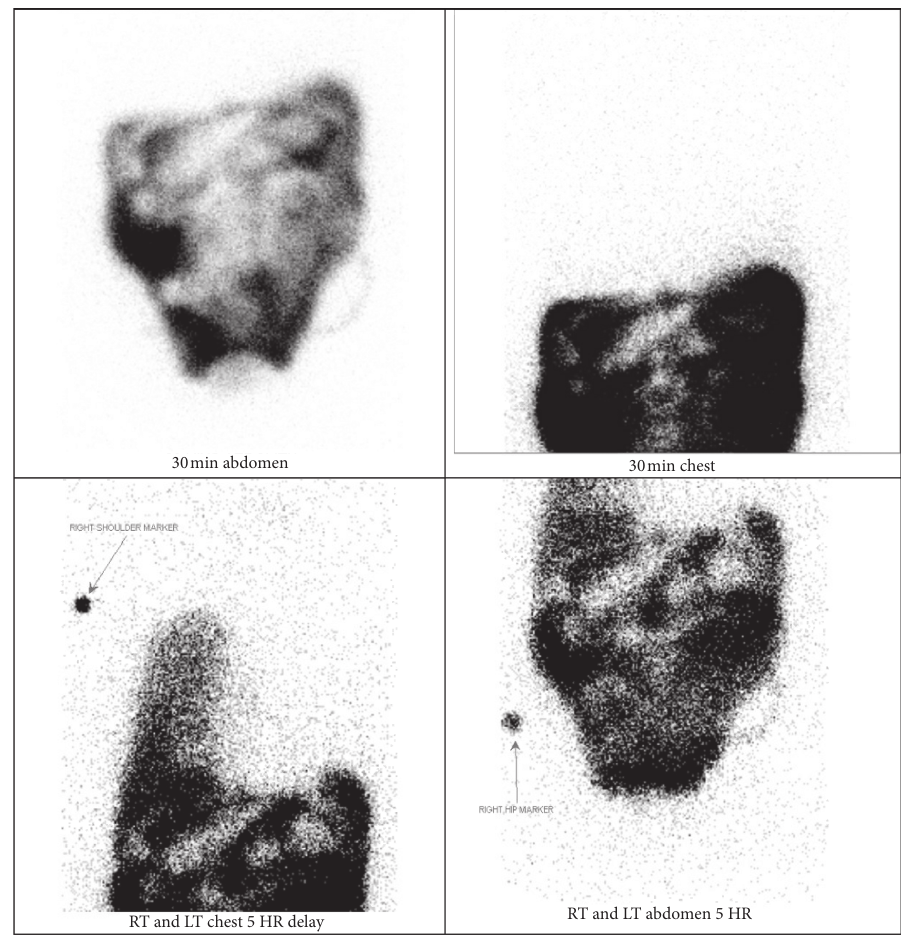
Figure 2: Right pleural-peritoneal fistula demonstrated on peritoneal scintigraphy after 5 th